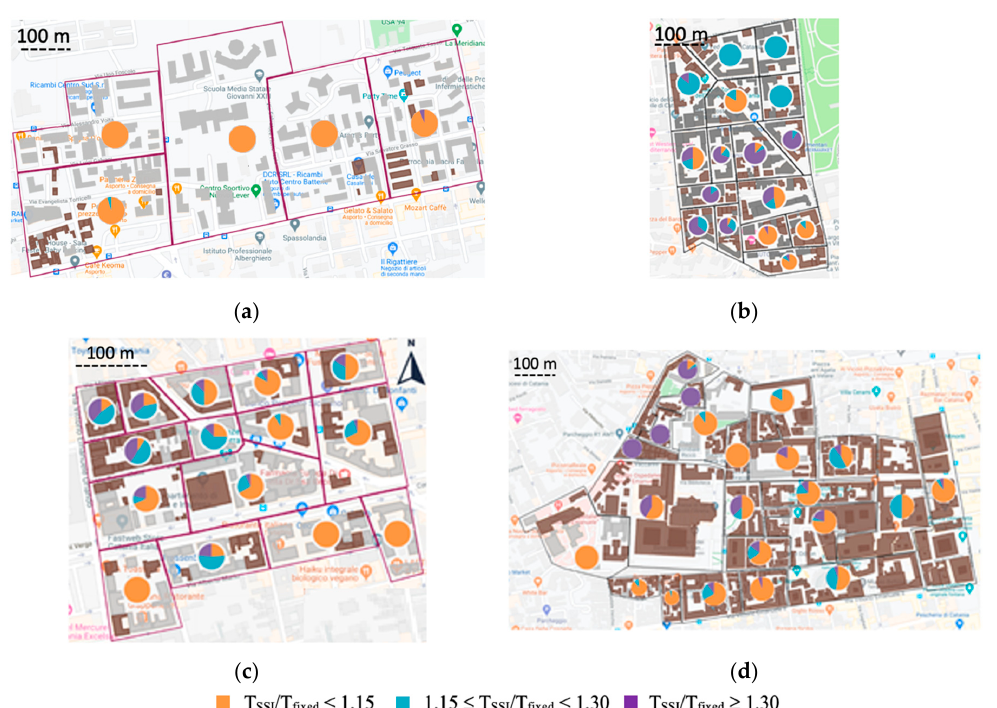
Figure 9. Spatial distribution of T SSI /T fixed for the investigated areas: ( a ) west area; ( b ) northeast area; ( c ) north Old Town; ( d ) south Old Town.